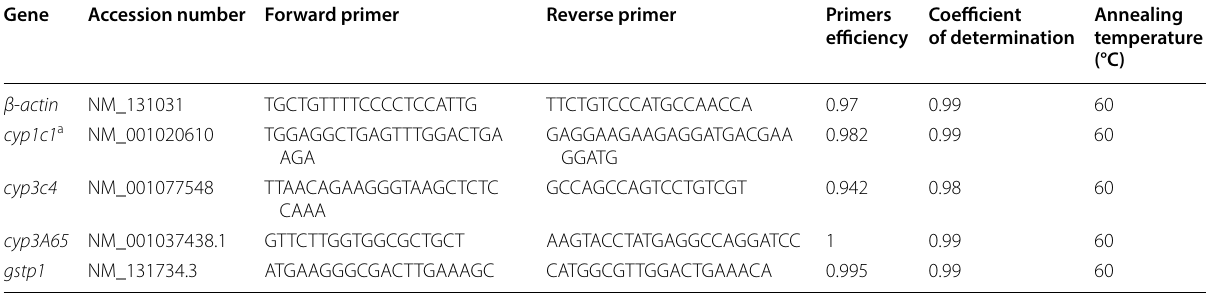
Table 1 Sequences and efficiencies of primers used in quantitative real-time PCR